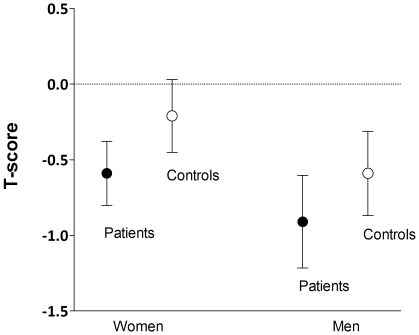
Mean QUS bone mineral density expressed as T-score (and 95% confidence interval) in HIV-infected patients and controls, separately for men and women.